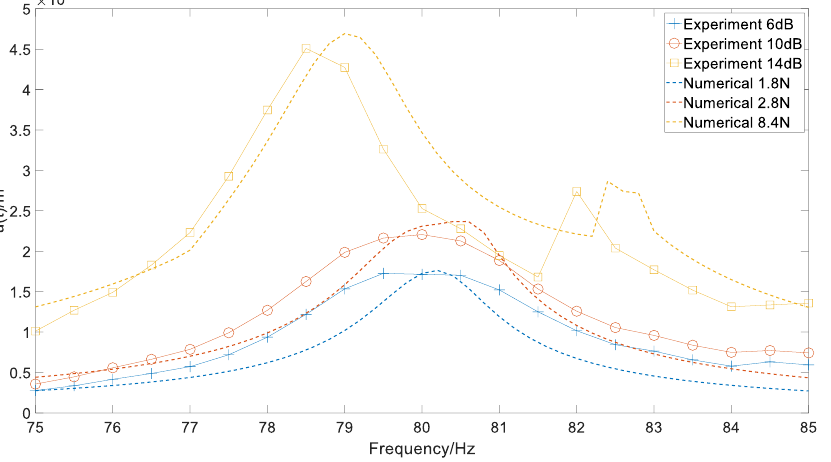
Figure 8. The comparison between the experimental and numerical responses of the acoustic dis- placement 𝑢(𝑡) of the system.